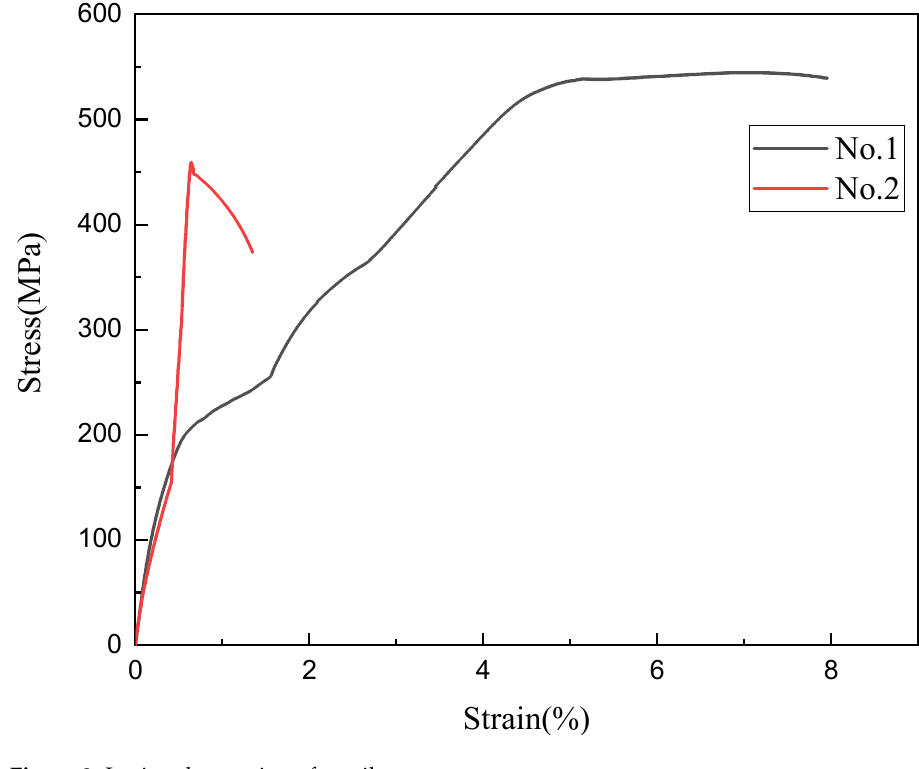
Figure 3. In situ observation of tensile curve.